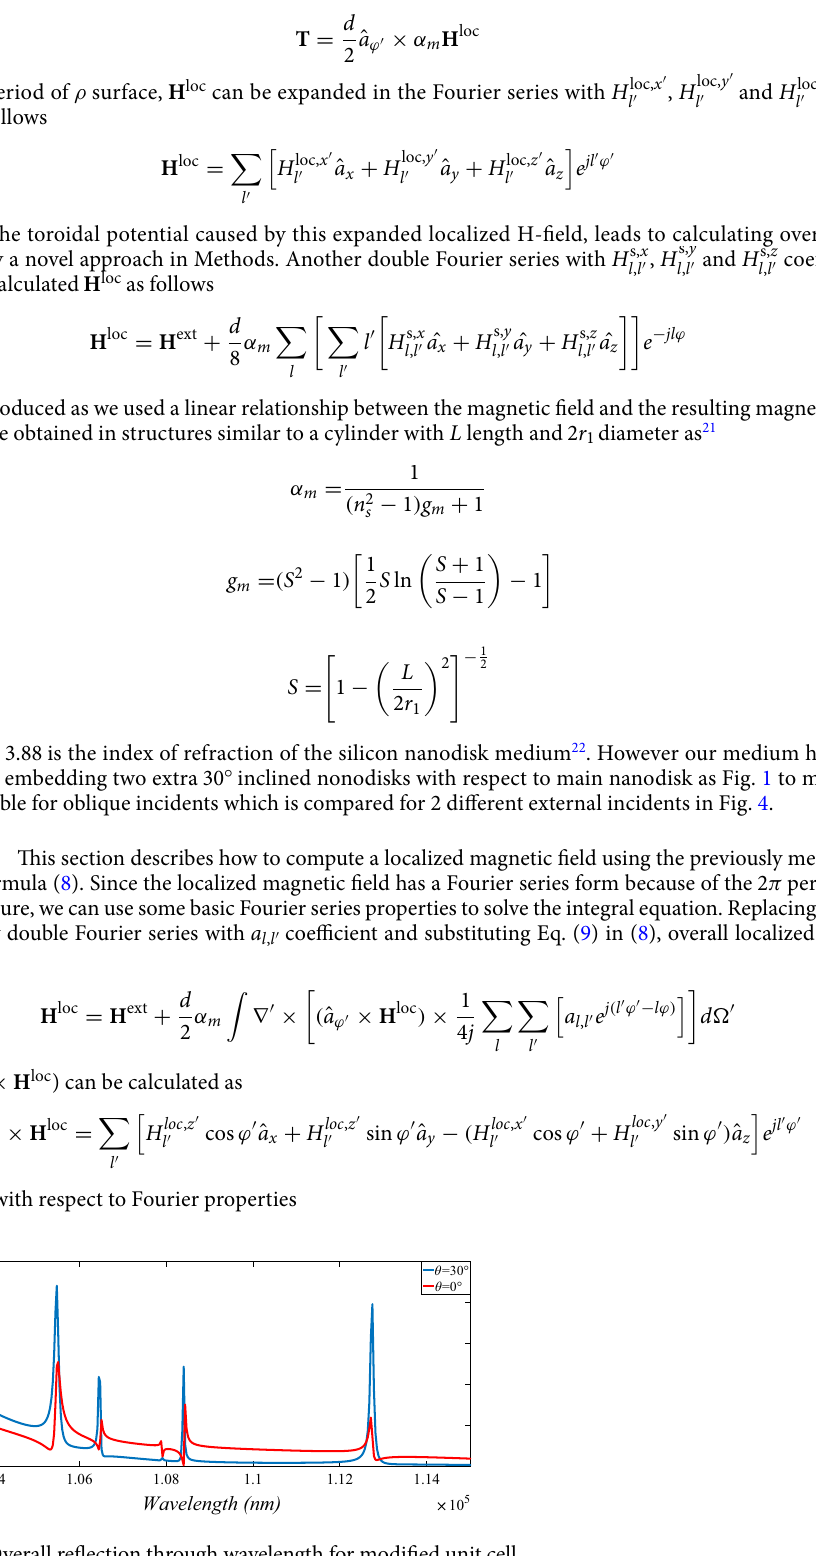
Figure 4. Overall reflection through wavelength for modified unit